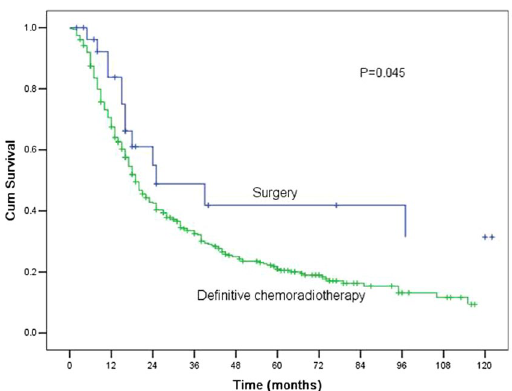
Figure 2. Comparisons of the survival curves for patients with cervical oesophageal cancer who received surgery and definitive chemoradiotherapy. The MST and the1-, 3-, and 5-year OS rates for patients who underwent surgery were 25.0 months (95% confidence interval (CI) 0.8–49.2 months), 83.8%, 48.8%, and 41.9%, respectively, which were significantly better compared with those of 19.0 months (95% CI 16.6–21.4 months), 67.4%, 32.5%, and 21.0%, respectively, for patients who received definitive chemoradiotherapy (P =